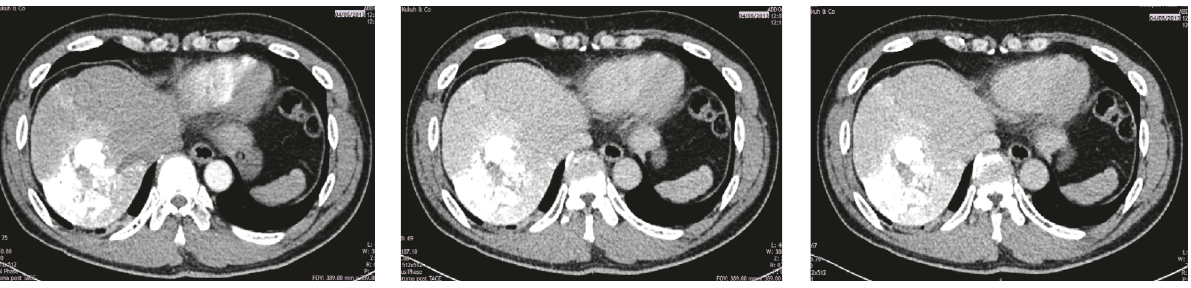
Figure 2: Arterial, venous, and delayed phase of Abdominal CT Scan after first DEB-TACE (January